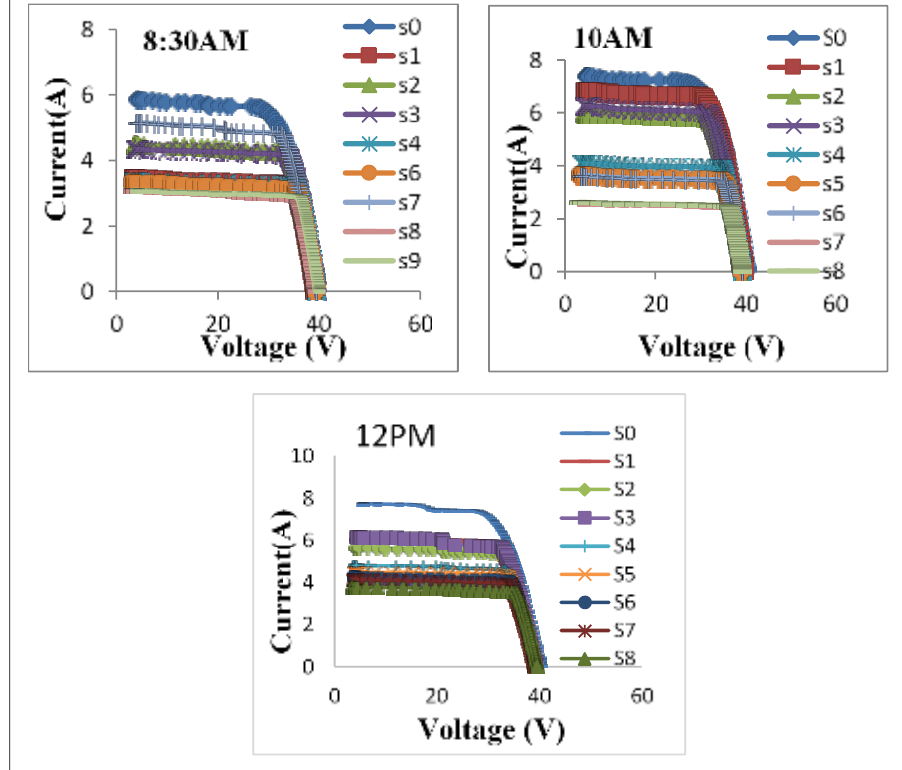
Figure 4: I-V Characteristics of solar panel at various times and